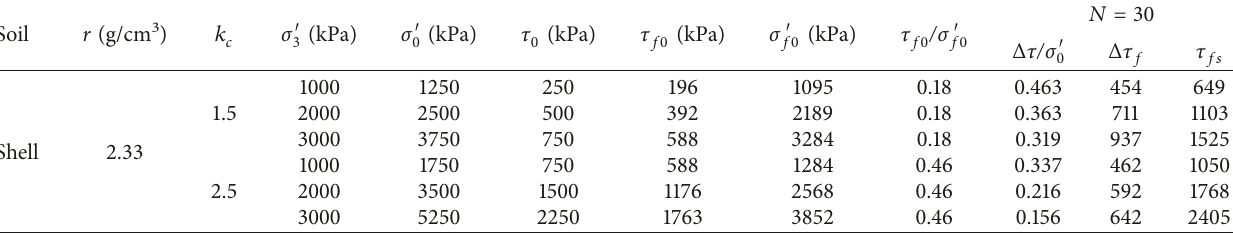
Table 1: Parameters of total shear strength.